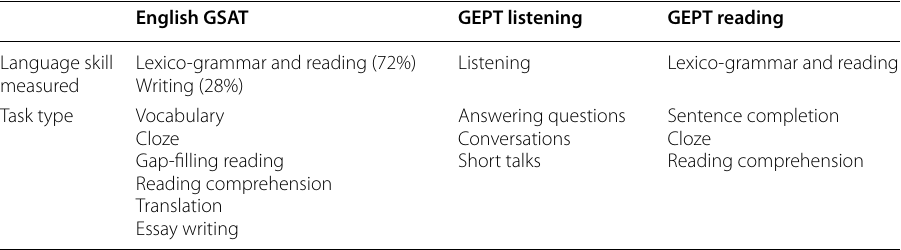
Table 2 The tests used for the current study English